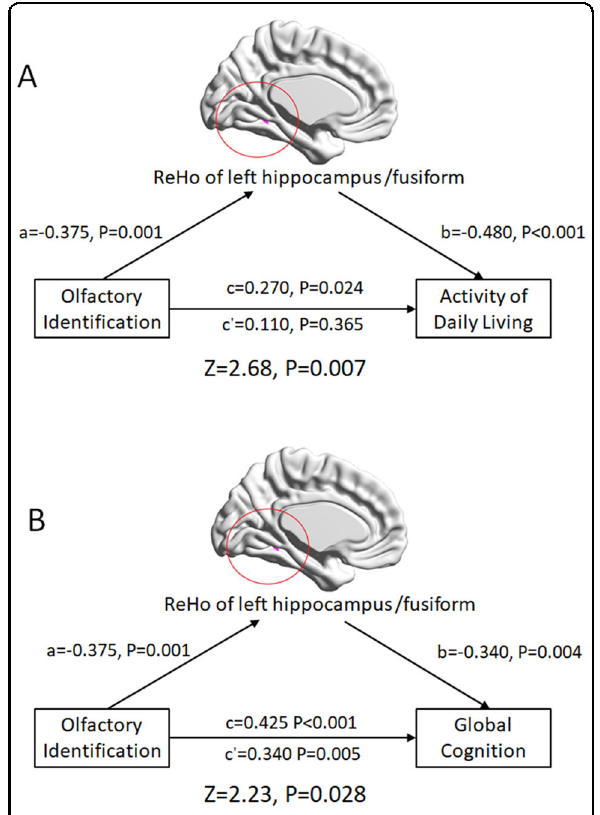
Fig. 4 Associations between OI and global cognition/ADL were mediated by ReHo of the left hippocampus/fusiform gyrus. The ReHo of the left hippocampus/fusiform gyrus was A a complete mediator of the relationship between OI and ADL, and B a partial mediator of the relationship between OI and global cognition.